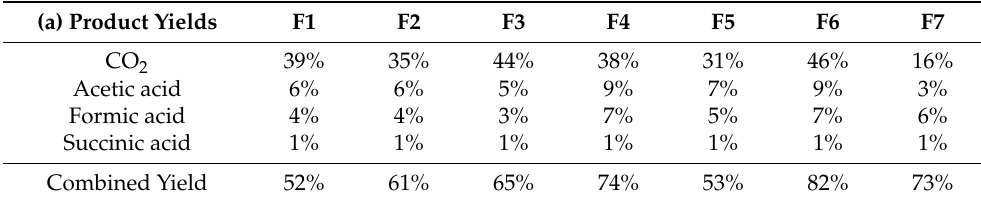
Table 5. Product yields using fructose-derived humins using different acids and solvents;